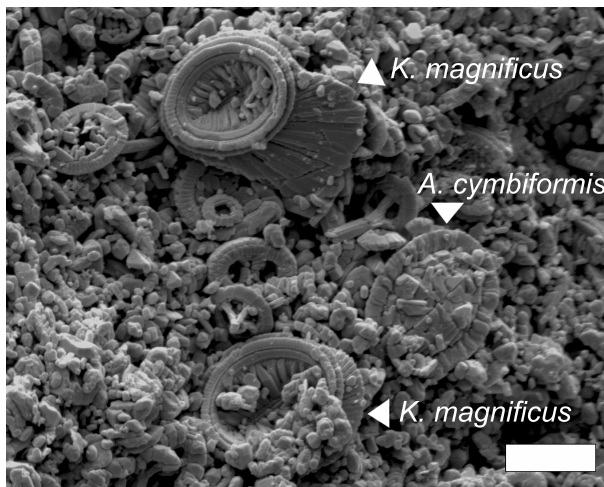
Figure 4. SEM picture of the Stevns-1 chalk. Sample 6146 (late Maastrichtian cooling episode, nannofossil subzone UC20b-c BP , depth: 73.91m). Two of the main cool-water nannofossil taxa are shown. Bar is